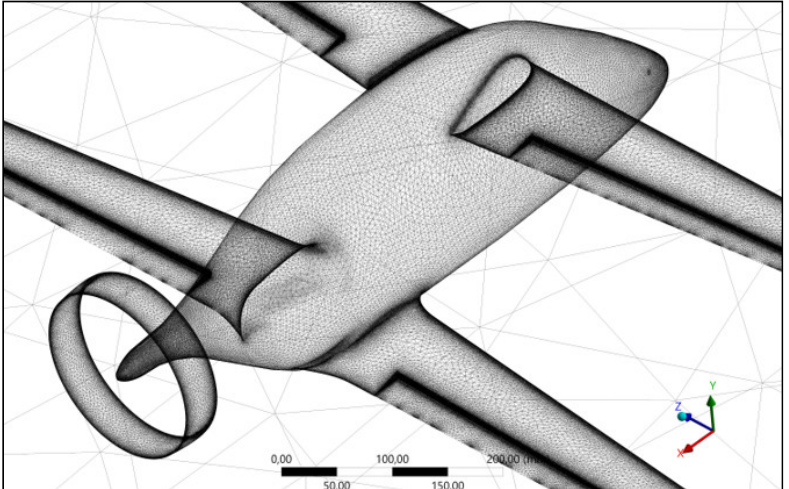
Figure 10. Fragment of the computational mesh of the CFD model with a tail duct.